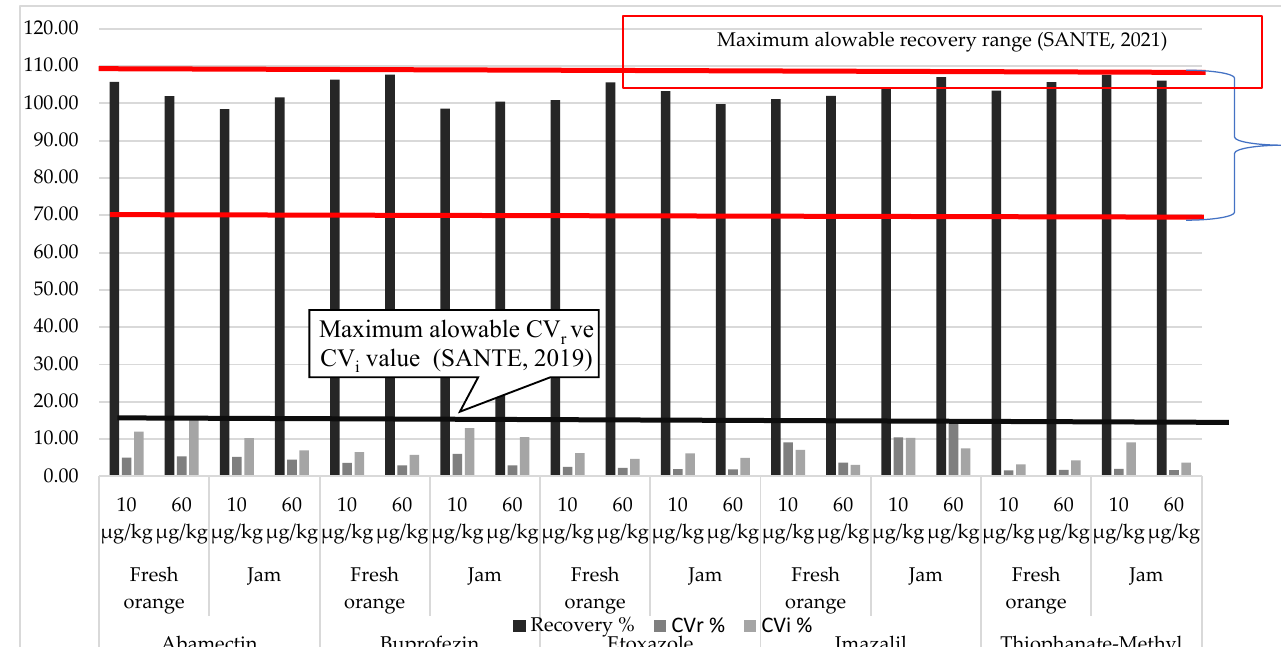
Figure 2. Method verification results (SANTE 2021).